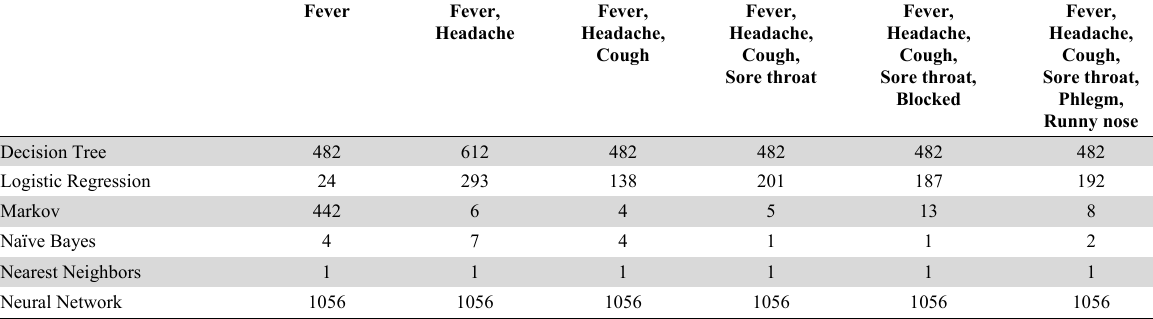
The number of THM classifications obtained from the identification of flu symptoms